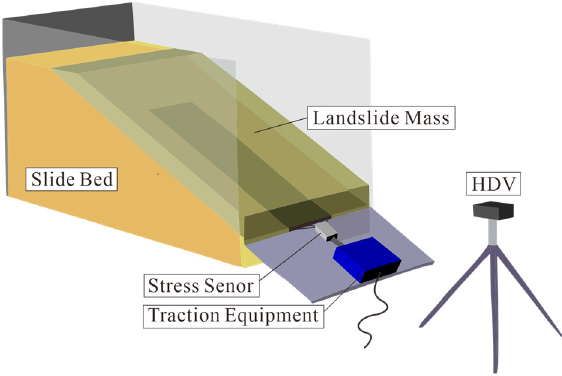
Figure 5. Schematic diagram of the physical model experiment system.